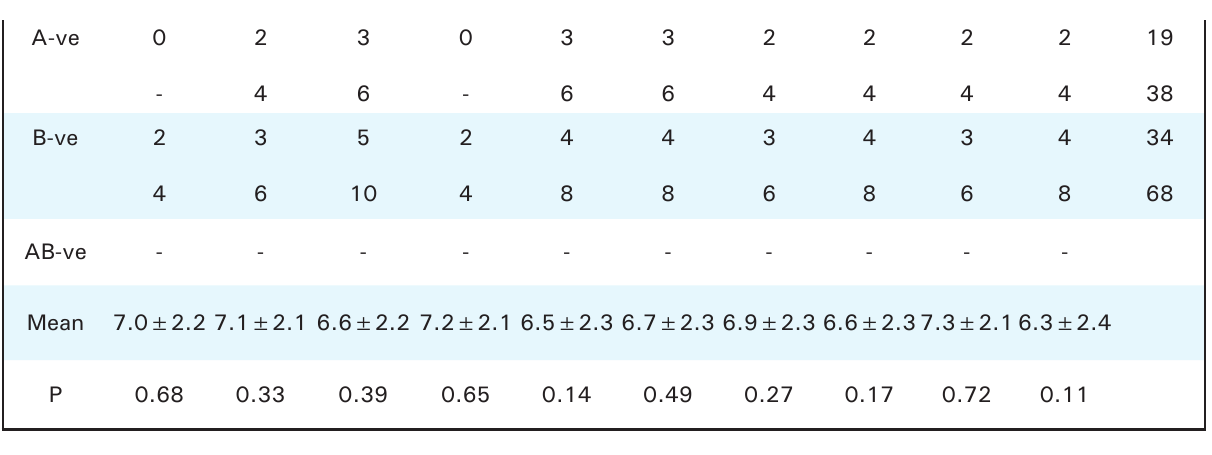
statistically no any association between mean of whorls in individual fingers when compared with different blood groups (P>0.05) (Table 4).